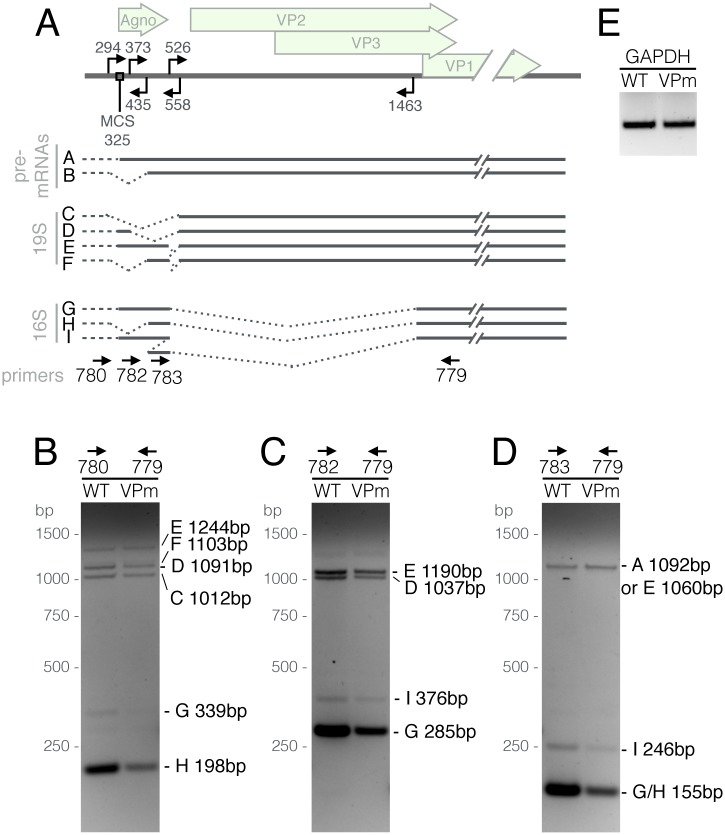
m6A does not detectably affect SV40 late transcript alternative splicing.(A) Schematic showing alternatively spliced isoforms of the SV40 late transcripts [45]. Arrows facing in the 3' direction denote 5’ splice sites, while 5'-facing arrows denote 3’ splice sites. Dashed lines at the 5' end of the transcripts represent the known variability of the late transcription start sites. MCS: Major cap site at position 325. Arrows at the bottom of panel A show the different primers used for RT-PCR. Total RNA from WT or VPm-infected cells was reverse transcribed and then subjected to PCR using primer sets 780/779 (B), 782/779 (C), 783/779 (D) Each band is labeled on the right with a letter denoting the spliced isoform it represents, and the expected PCR product size. (E) A GAPDH primer set was used as a loading control.